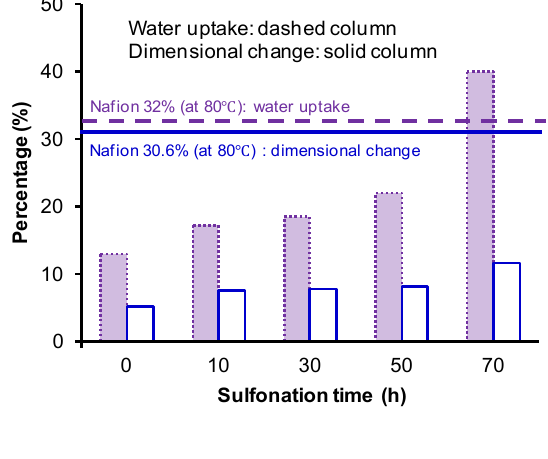
Figure 8. Water uptake and dimensional change of sc - OPBI as a function of the sulfonation